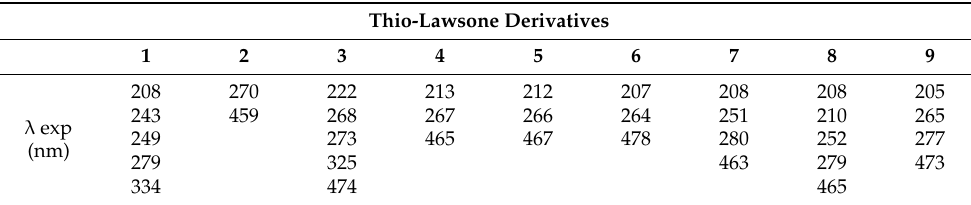
Figure 2. UV/Vis absorption spectra of compounds 1 , 2 , and 3 in methanol. Spectra for all compounds are presented in supporting information. Table 3. Experimental UV/Vis spectrum in methanol.